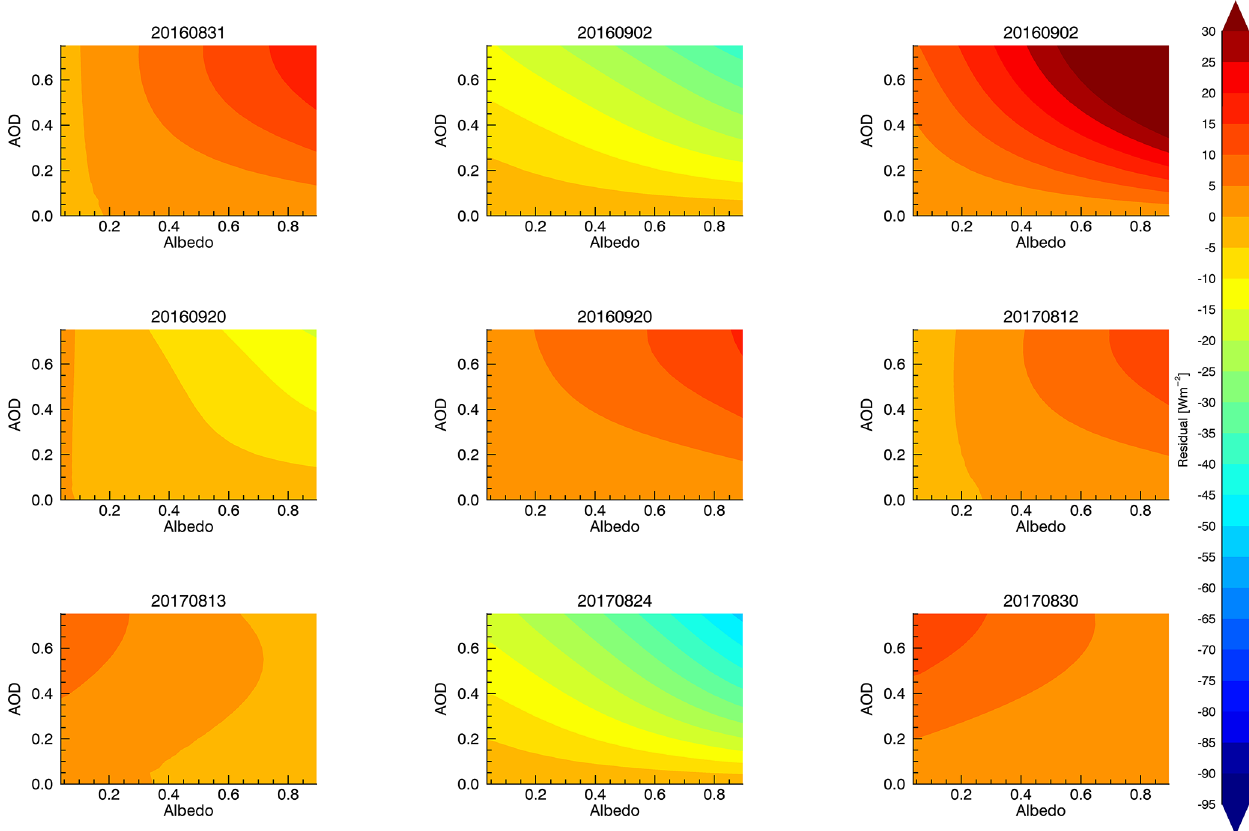
Figure D1. Residual plot of directly calculated DARE (RTM output) and predicted BB DARE values using P DARE at a fixed SZA (20 ◦ ).